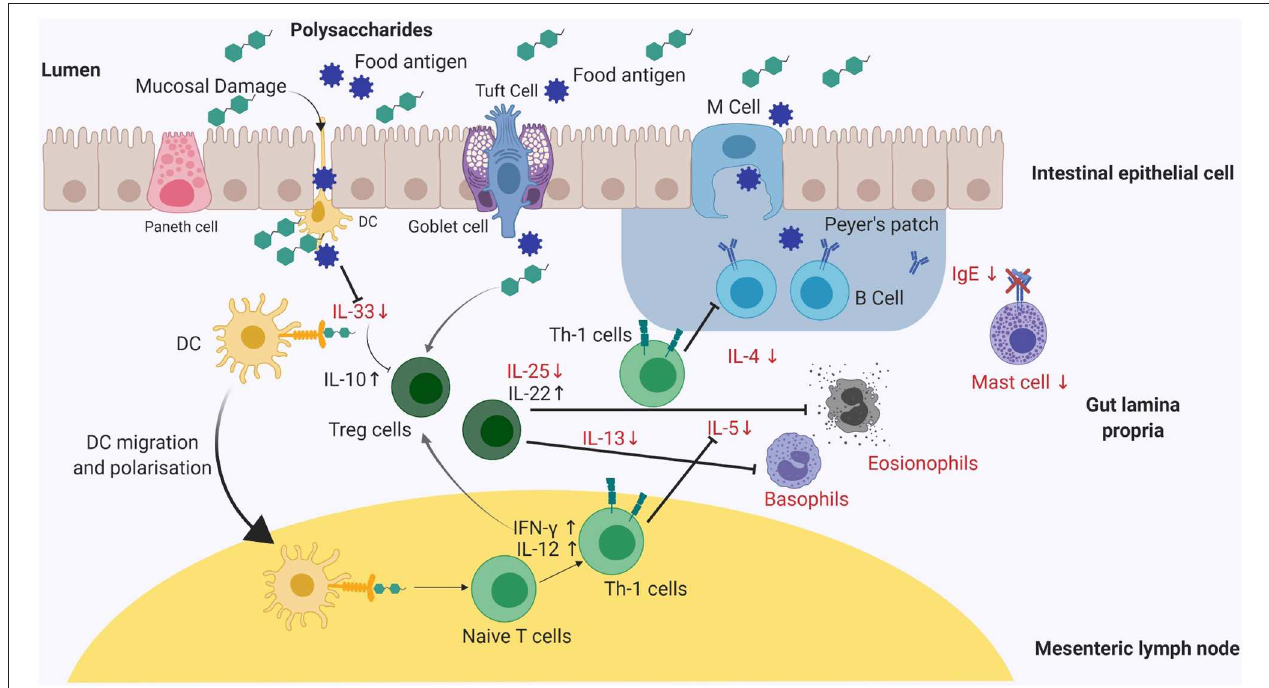
FIGURE 2 | A graphical summary of the effects on different cell populations and cytokines, involved in an allergic immune response, after exposure to polysaccharides, herbal medicinal plants or traditional Chinese medicine. The reported mode of action of either natural polysaccharides or medicinal plants appears to be quite similar in murine models. Mice supplemented with abovementioned sources demonstrates reduced allergen-specific IgE antibody responses and a marked reduction in clinical symptom severity including diarrhea and drop in temperature (clinical symptoms not shown). Reduced IgE expression levels inhibits mast cell degranulation leading to symptomatic relief. Polysaccharides and medicinal plants mediate Th-1 pathway by expressing IFN- γ , IL-10, IL-12, and IL-22 maintaining the intestinal epithelial barrier function and preventing antigen presentation to dendritic cells (DC). Reduced levels of chemokines such as IL-25 and IL-33 results in decreased antigen presentation on DC’s. Th-1, T-helper-1; DC’s, Dendritic cells; IL, Interleukin; IFN- γ , Interferon gamma.